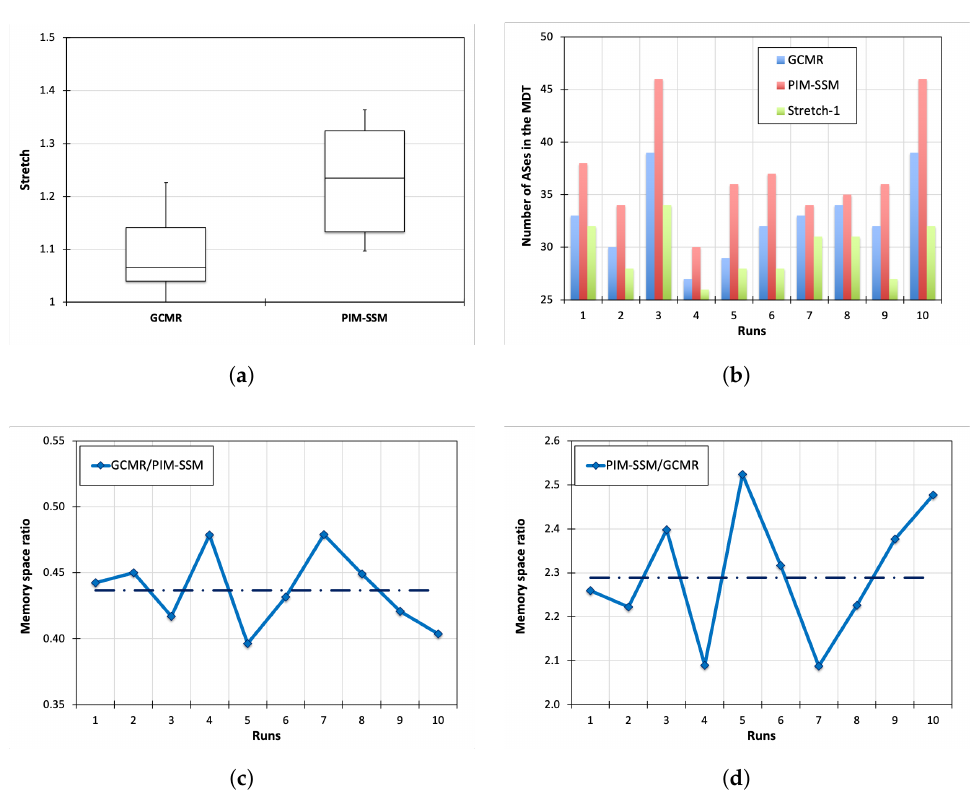
Figure 11. Comparison between GCMR and PIM-SSM in the emulation platform: ( a ) stretch; ( b ) num- ber of ASes in the MDT; ( c ) routing table size ratio; ( d ) communication cost